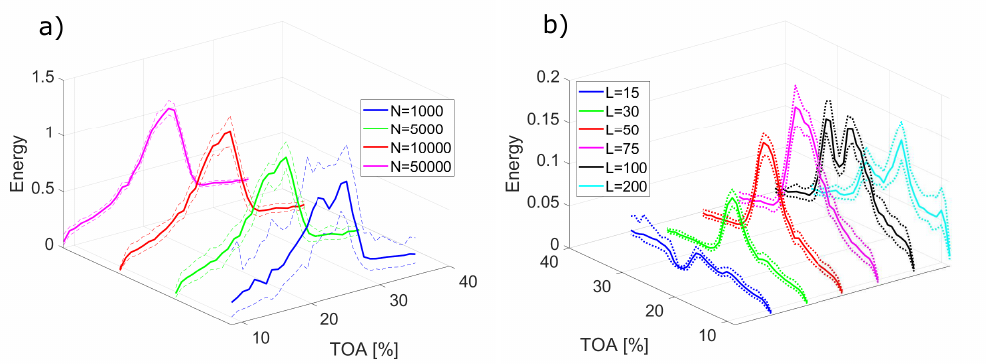
Figure 8. Mean energy E (solid lines) and confidence interval (dashed lines) for different method parameters: ( a ) varying signal length N for L = 50; ( b ) varying window length L for N = 10,000.